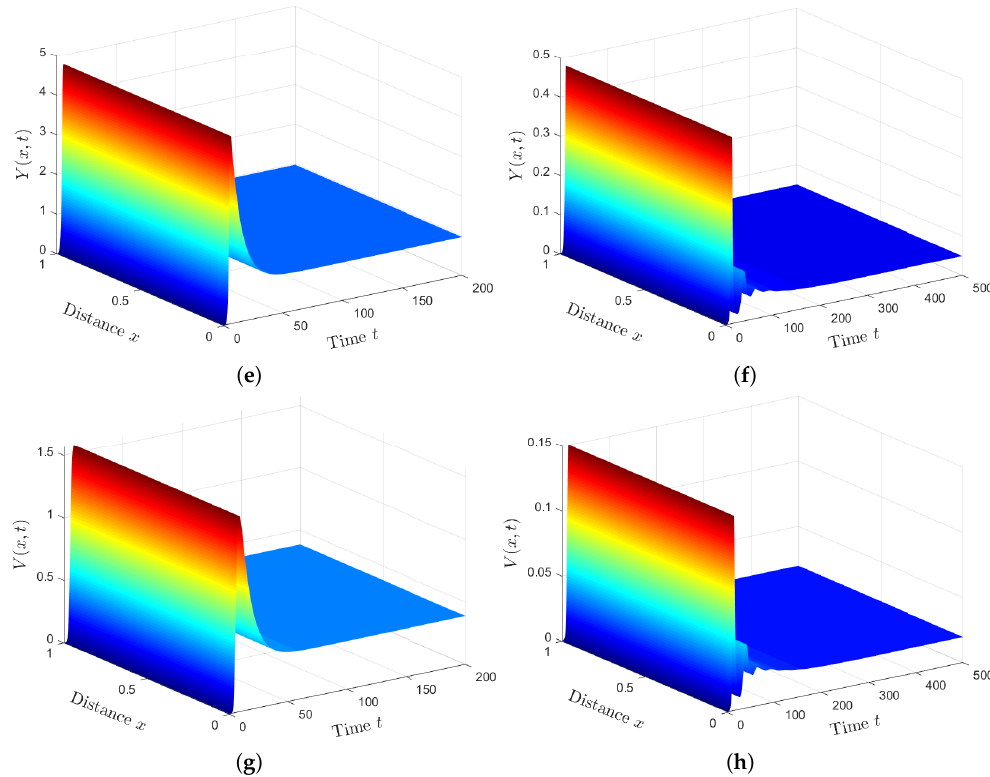
Figure 5. Comparison between SARS-CoV-2 single infection and HTLV-I/SARS-CoV-2 co-infection. ( a ) Healthy ECs for system (49)–(52). ( b ) Healthy ECs for system (12)–(18). ( c ) Latent infected ECs for system (49)–(52). ( d ) Latent infected ECs for system (12)–(18). ( e ) Active infected ECs for system (49)–(52). ( f ) Active infected ECs for system (12)–(18). ( g ) SARS-CoV-2 for system (49)–(52). ( h ) SARS-CoV-2 for system